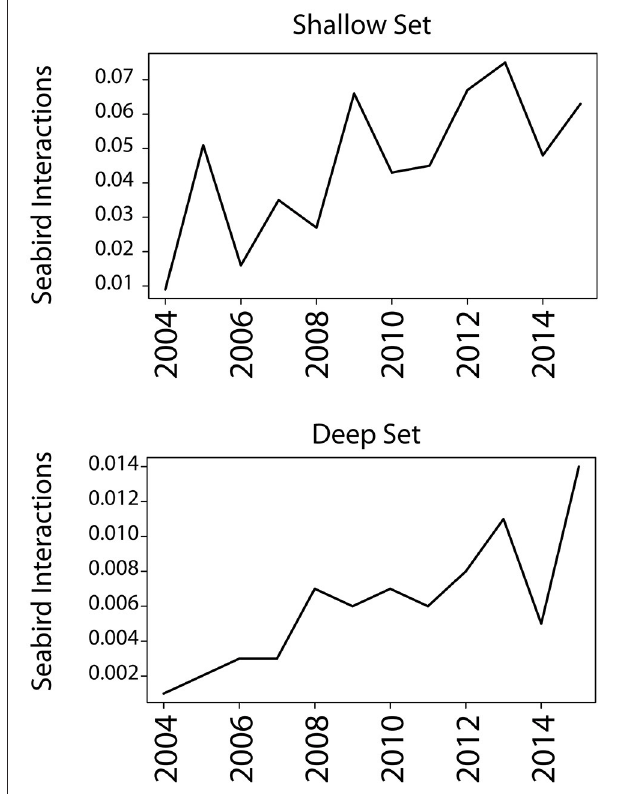
FIGURE 6 | Seabird interactions with Hawaii longline fisheries in the central Pacific are increasing. Seabird interaction rate was measured as the number of interactions per 1,000 hooks; interactions are defined as a bird caught on a hook, whether dead or alive. Interactions across 2004–2015 increased in both deep and shallow set longline fisheries. Species included in the count are black-footed albatrosses, Laysan albatrosses, and sooty shearwaters; however, the two albatross species represent > 90% of all interactions across the years. Data was taken from the 2015 Annual Report “Seabird